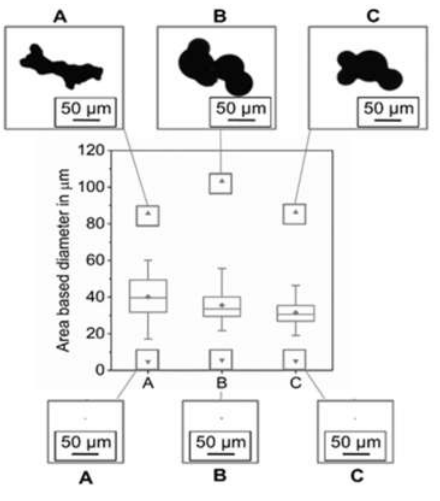
Figure 4. Particle shape distributions. 3.2. PBF-LB/M Densification and Microstructures After PBF-LB/M-processing of the three starting powders, the remaining porosity of the cuboid specimens was determined by quantitative image analysis. The results are pre- sented in Figure 5. By applying the standard PBF-LB/M parameter set recommended by the system manufacturer (Table 3), the samples, A-PBF, show the lowest porosity of 0.24% compared to the samples B-PBF and C-PBF. The samples B-PBF and C-PBF, which possess